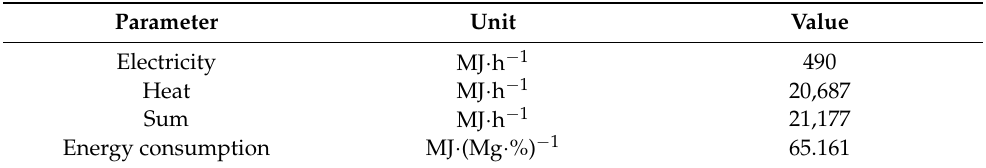
Table 7. Energy demand and energy consumption of the DT2532 dryer.